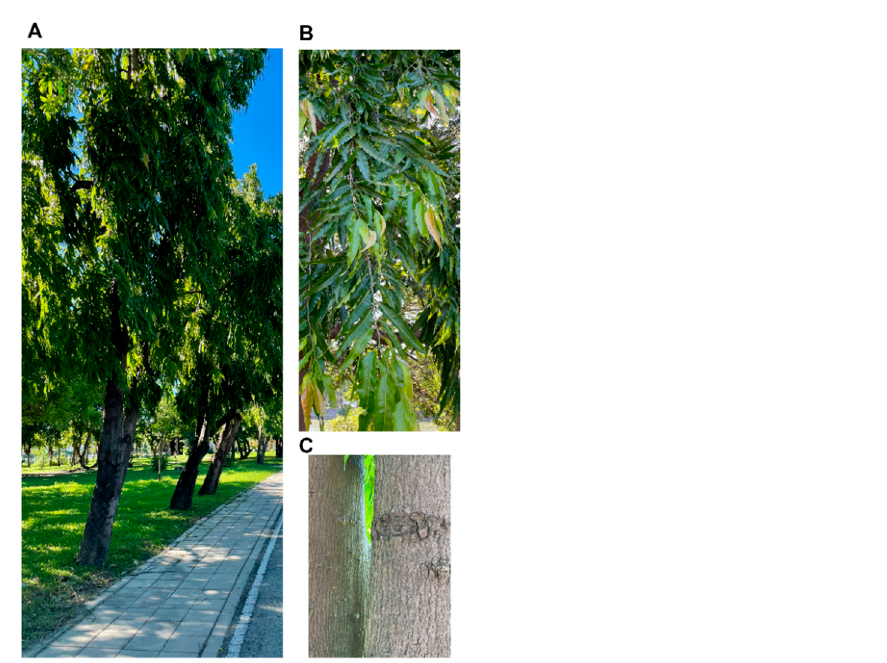
Figure 1. Photographs of P. longifolia Sonn. Thwaites pendula. ( A ) The whole tree, ( B ) leaves, and ( C ) stem bark of P. longifolia . Photos were shot at Kaohsiung, Taiwan, in 17 August, 2021. Methods for Extraction of Phytochemical Compounds from Polyalthia